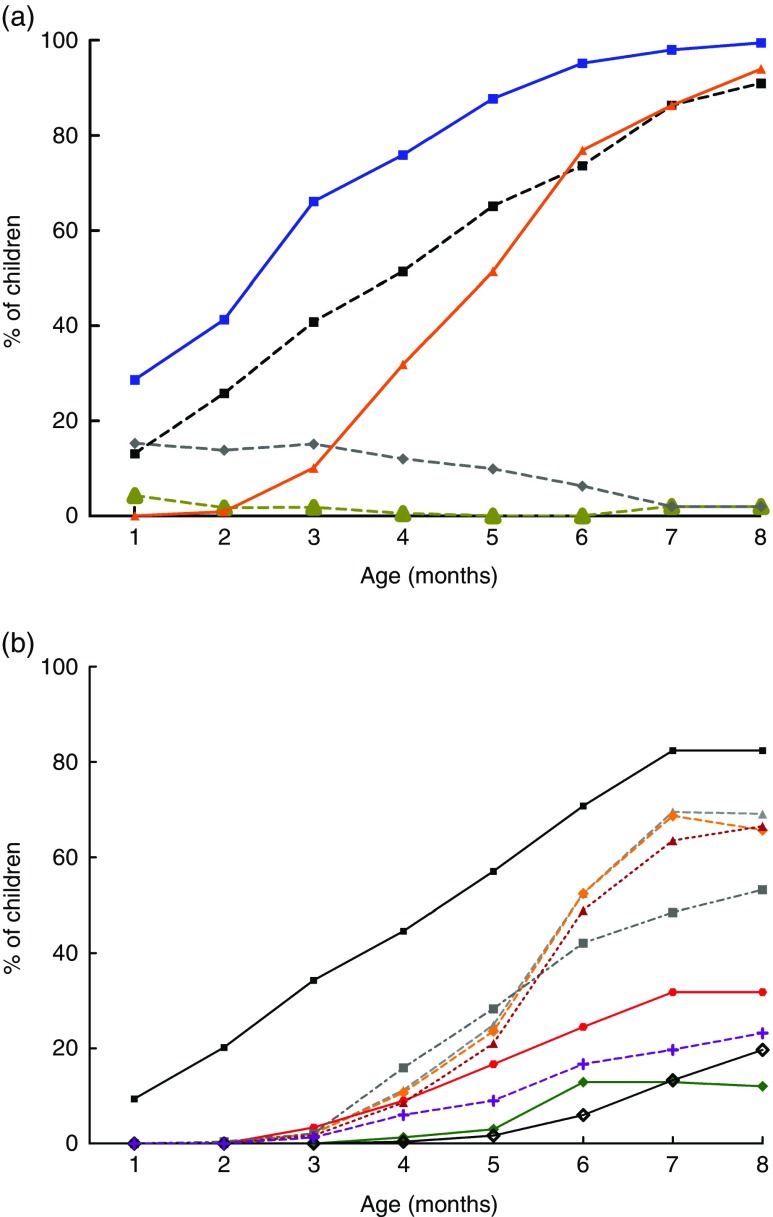
(colour online) Infant complementary feeding practices from 1 to 8 months in the Brazilian MAL-ED cohort site (n 233): (a) introduction of liquids (, tea/coffee; , infant formula; , other milks; , water; , juice); (b) introduction of solids/semi-solids (, grains; , yellow, orange or red fruits; , roots; , dairy products; , yellow or orange vegetables; , dark green leafy vegetables; , other fruits or vegetables; , beans; , meat)